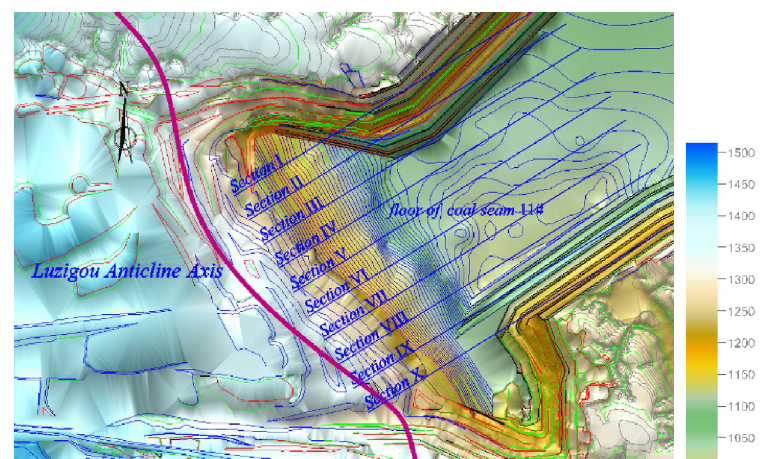
Fig. 11 Geological features of Luzigou anticline region in